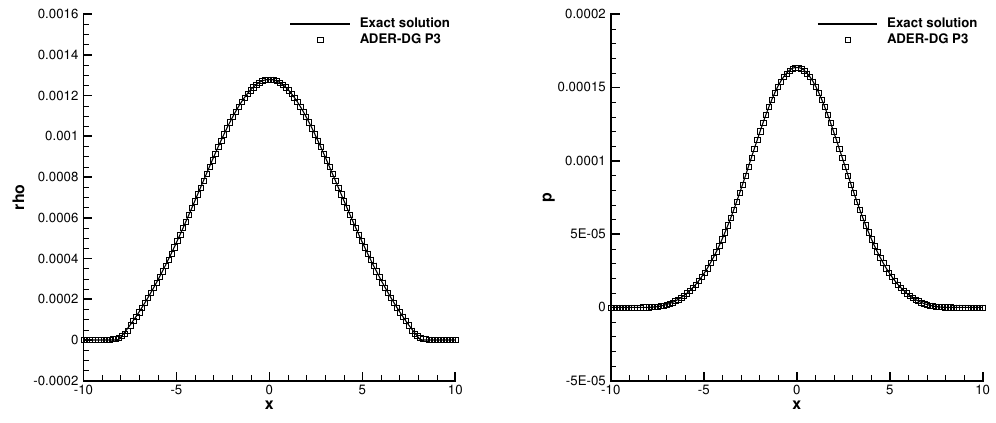
Figure 8. Computational results for a stable 3D neutron star. Comparison of the numerical solution with the exact one at time t = 1000 on a 1D cut along the x -axis for the rest mass density ( left ) and the pressure ( right ).